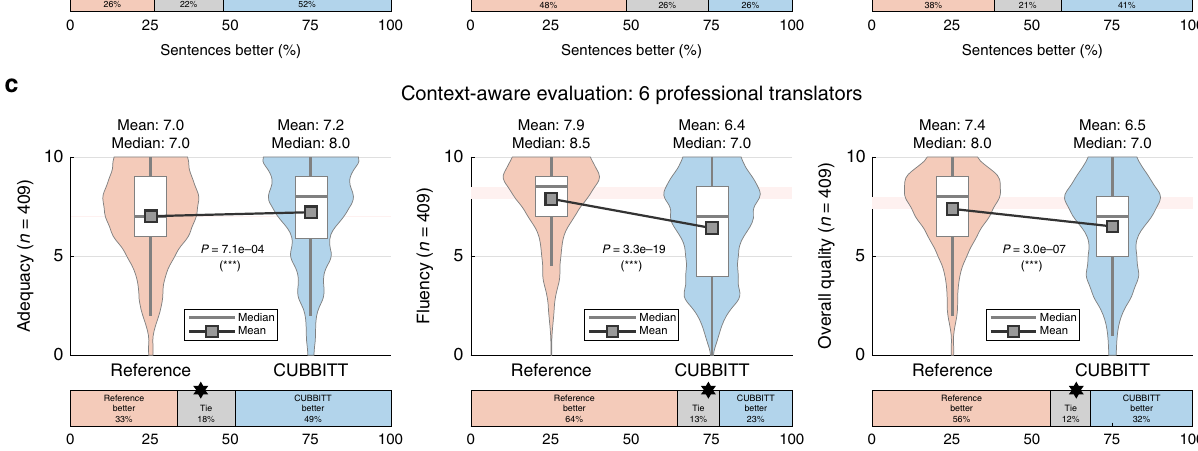
Fig. 3 CUBBITT outperforms human translation in adequacy. a Results from context-unaware evaluation in WMT18, showing distributions of source- based direct assessment (SrcDA) of fi ve MT systems and human reference translation, sorted by average score. CUBBITT was submitted under the name CUNI-Transformer. Online G, A, and B are three anonymized online MT systems. b Translations by CUBBITT and human reference were scored by six non- professionals in the terms of adequacy, fl uency and overall quality in a context-aware evaluation. The evaluation was blind, i.e., no information was provided on whether the translations are human or machine translated. The scores (0 – 10) are shown as violin plots with boxplots (median + interquartile range), while the boxes below represent the percentage of sentences scored better in reference (orange), CUBBITT (blue), or the same (gray); the star symbol marks the ratio of orange vs. blue, ignoring gray. Sign test was used to evaluate difference between human and machine translation. c As in a , but evaluation by six professional translators. *** P < 0.001; ** P < 0.01; * P <